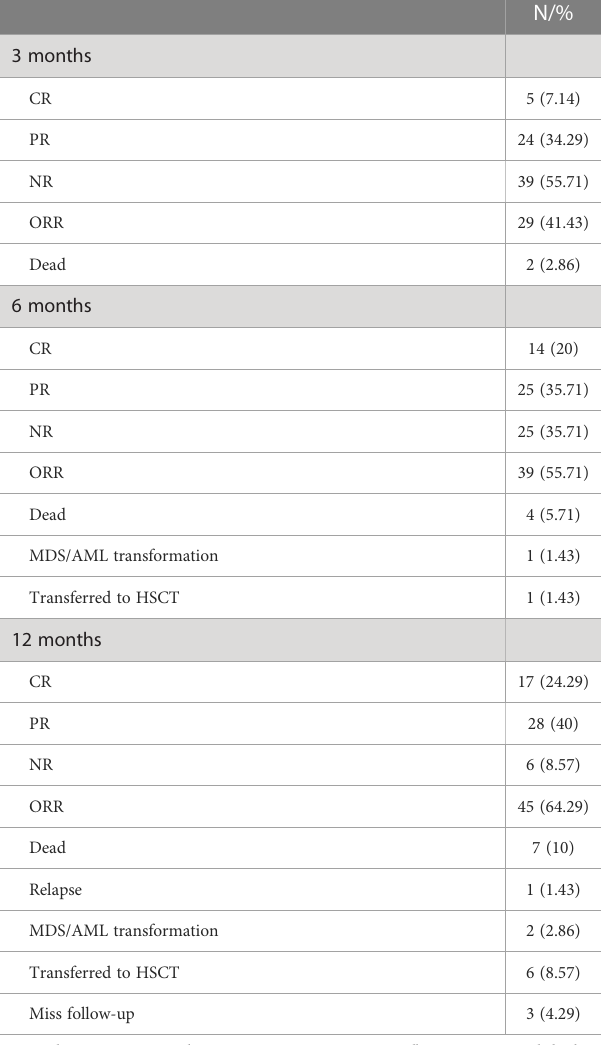
TABLE 2 Treatment response of patients in the IST group